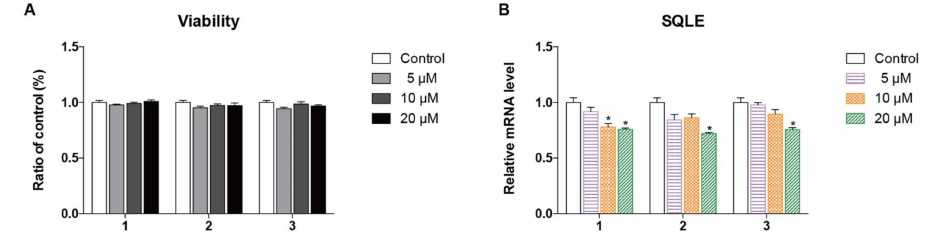
Figure 3. Cytotoxicity of compounds 1 – 3 in HepG2 cells was measured using the MTT assay. Statistical analysis was performed using a one-way analysis of the variance (ANOVA) followed by Bonferroni’s multiple comparison tests. All error bars are S.E.M ( A ). Change in the mRNA expression level of the SQLE gene in cells treated at different concentrations. The transcription level of SQLE gene was normalized by an internal CD36 mRNA control. The data are expressed as the mean ± S.E.M ( n = 3). * p < 0.05 vs. control ( B